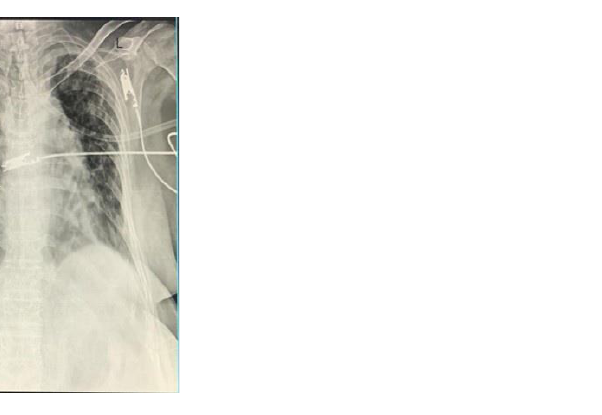
Figure 1. Chest X-ray showing bilateral infiltration with ring shadow suggestive of bronchiectasis.